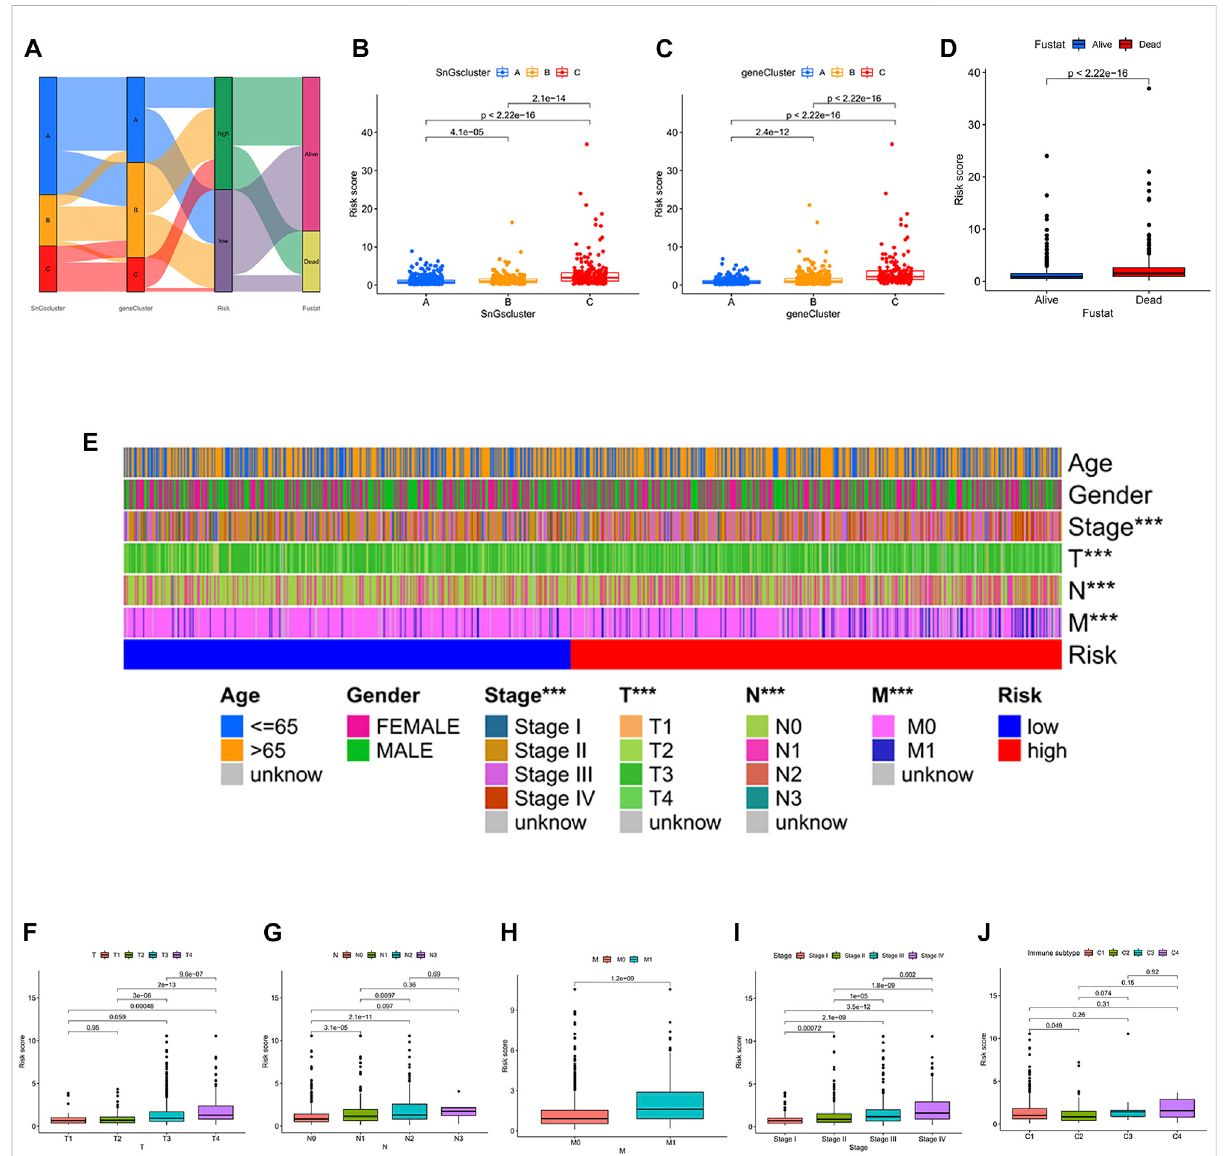
FIGURE 7 (A) Sankey diagram. The construction process of the risk score signature. (B) Box plot of risk scores for the three clusters. (C) Box plot of risk scores for the three gene clusters. (D) Box plot of risk scores for the survival status (Fustat). (E) Heatmap of correlation between risk and clinical characteristics. ppp p < 0.001. (F) Box plot of the risk score for the T stage. (G) Box plot of risk scores for the N stage. (H) Box plot of risk scores for M stage. (I) Box plot of risk scores for pathological TNM stage. (J) A box plot of risk scores across the four immune subtypes. C1, Wound Healing; C2, IFN-gamma Dominant; C3, In fl ammatory; C4, Lymphocyte